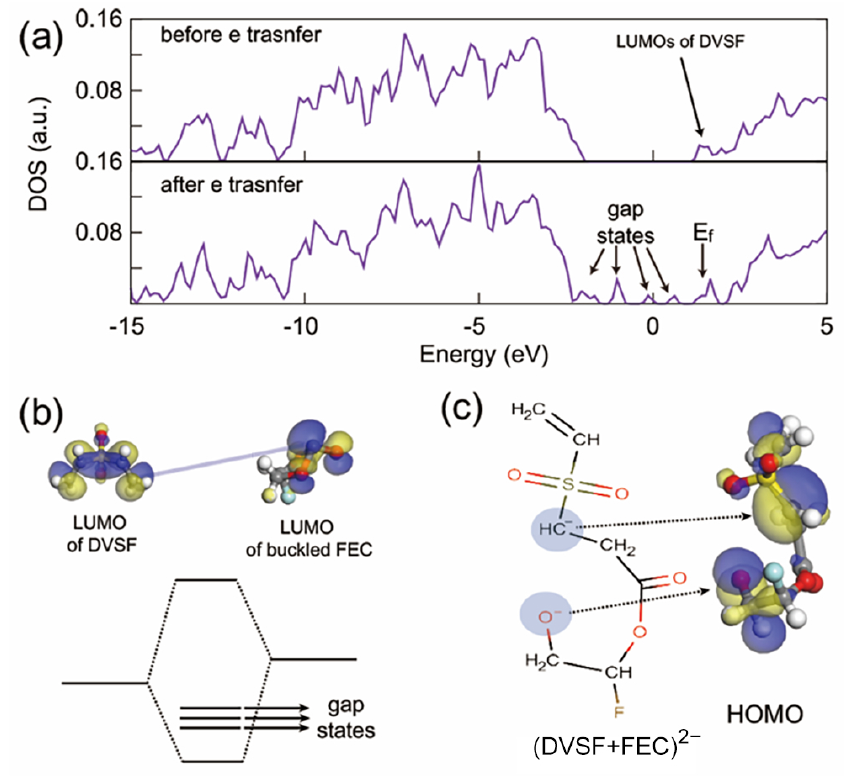
Figure 5. ( a ) Total density of states (TDOS) of the electrolyte mixture. The LUMO of divinyl sulfone (DVSF) was also the LUMO of the whole electrolyte system; therefore, additional electrons occupied this state. ( b ) There was an interaction between the partially occupied LUMO of DVSF with the unoccupied LUMO level of buckled FEC. Therefore, this interaction resulted in a C–C bond that, in turn, formed radicals with higher molecular weights. ( c ) The electronic wave function of the gap state confirmed that the electrons were indeed located at the positions of the radicals that were marked in the molecular